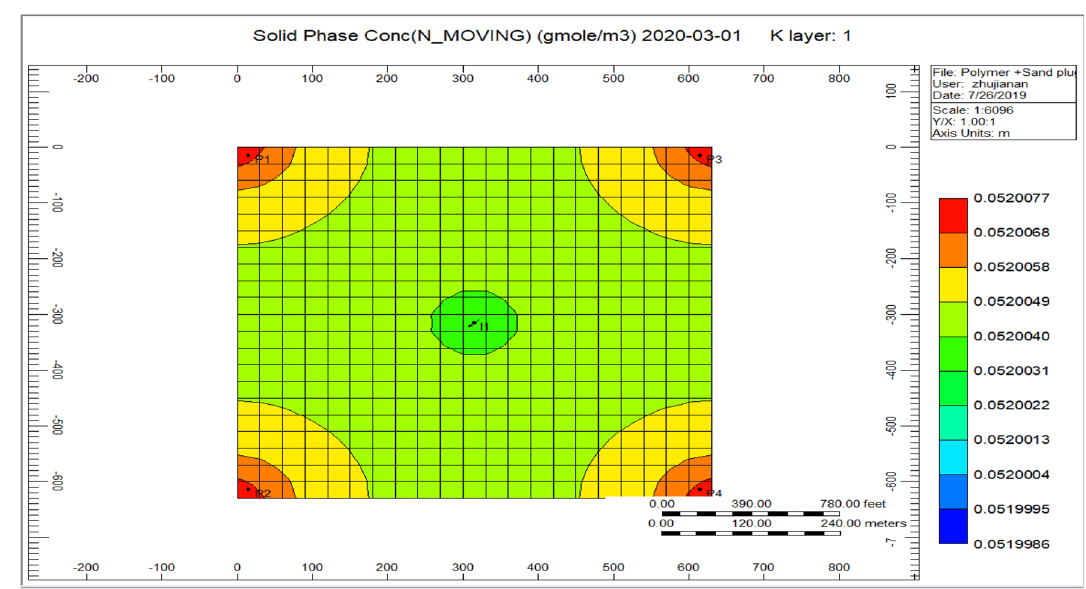
Figure 5. Indicates the presence of a concentration of sand nearby the production well CMG STARS 2017.10 URL: https:// www. cmgl.